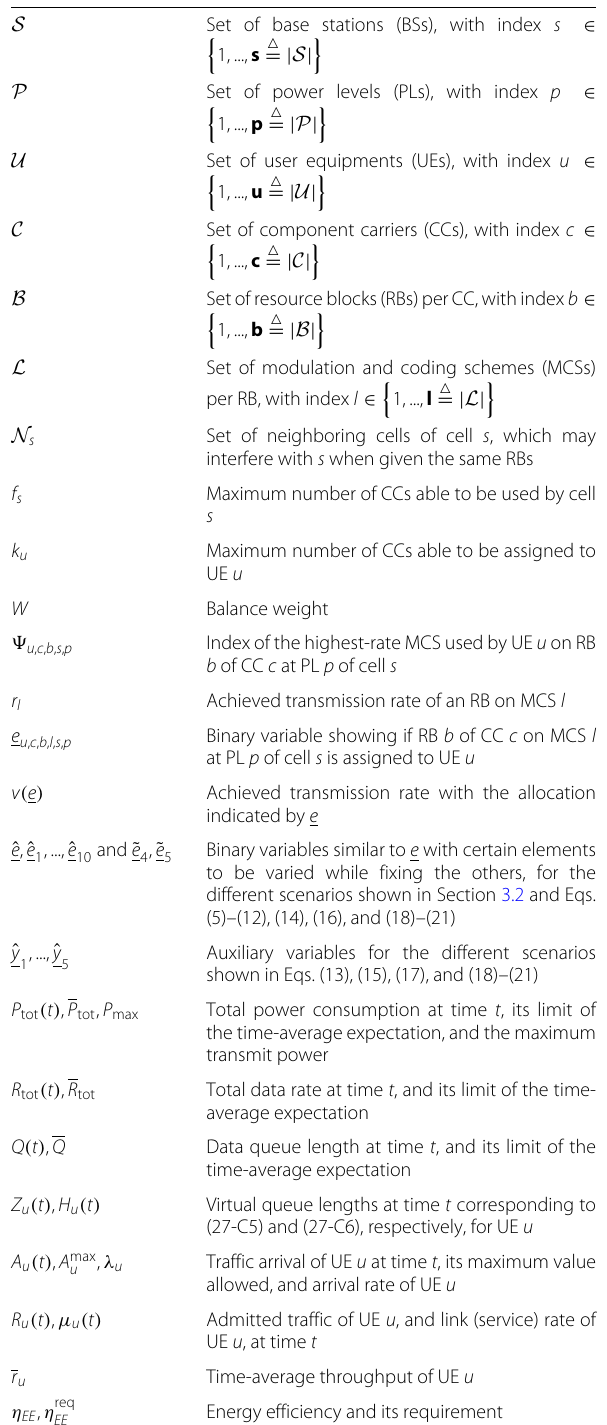
Table 1 A list of important symbols used in the problem